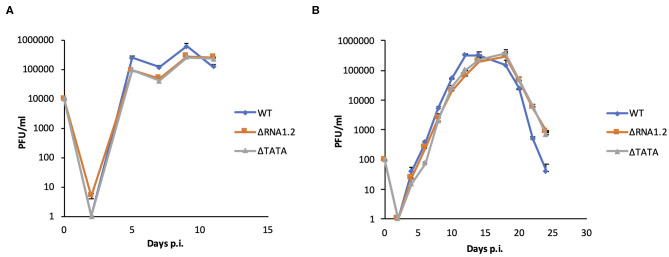
Growth curves of WT and RNA1.2 mutants. HFFF2 cells were infected with WT, ΔRNA1.2 or ΔTATA at (A) MOI = 1 or (B) MOI = 0.01 for 2 h, after which the medium was replenished. At each time point, the medium was replaced with fresh medium, which was harvested and titrated for cell-free infectious virus by plaque assay in duplicate. The results of one of three independent experiments are shown. Error bars denote standard deviation values. PFU, plaque-forming units.